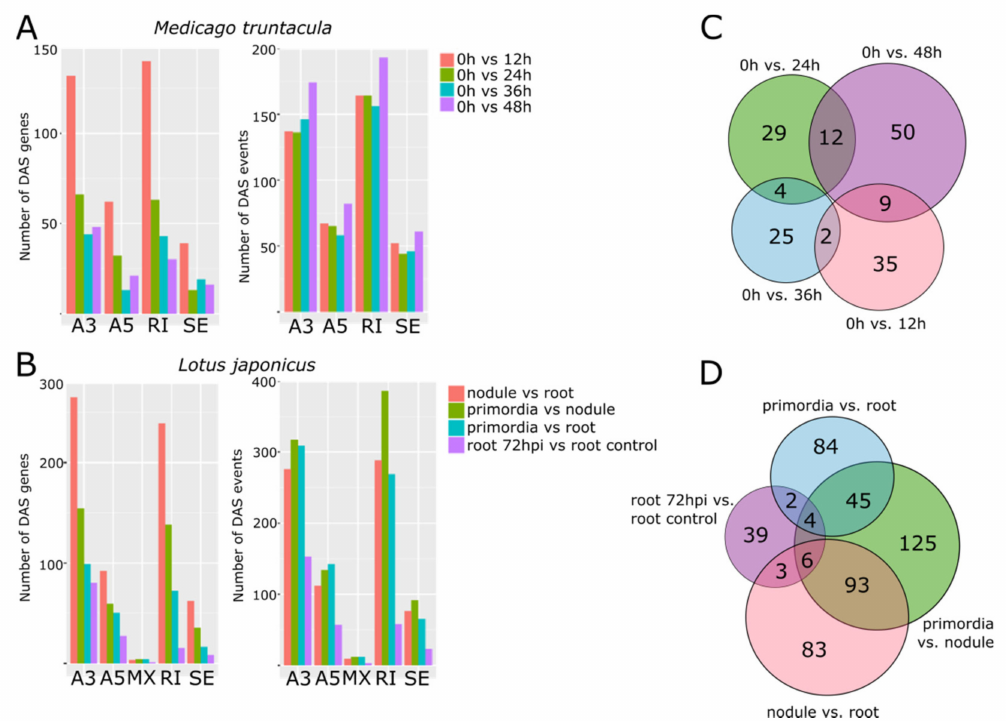
Figure 4. Alternatively processed mRNAs profile during nodule development in M. truncatula and L. japonicus . Alternative isoforms between samples were identified using SUPPA. The number of genes or events (indistinguishable from what gene) su ff ering Di ff erential Alternative Splicing (DAS) were scored in ( A ) M. truncatula and ( B ) L. japonicus . A3 and A5 stand for Alternative processing of the 5 (cid:48) and 3 (cid:48) ends, respectively; IR stands for Intron Retention; MX stands for Mutually exclusive Exons, and ES stands for Exon Skipping. The identity of the DAS genes was compared between samples showing little overlapping in ( C ) M. truncatula and ( D ) L. japonicus